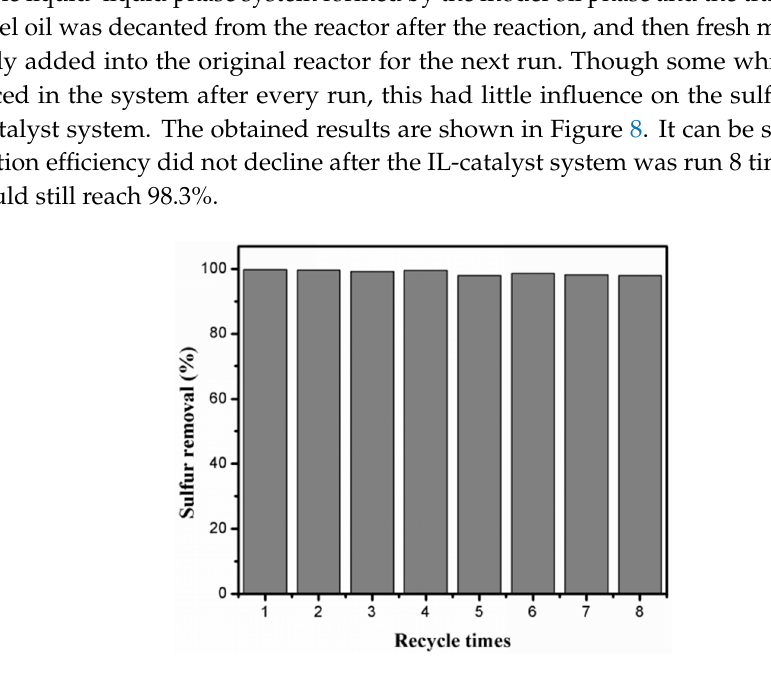
Figure 8. Recyclability of catalyst. Conditions: Model oil = 5 mL, n ([Bmim] 5 PMo 11 Co(H 2 O)O 39 ) = 4 µ mol, n (H 2 O 2 )/ n (DBT) = 5, T = 50 °C for 60 min with [Omim]BF 4 (1 mL) as the extractant.